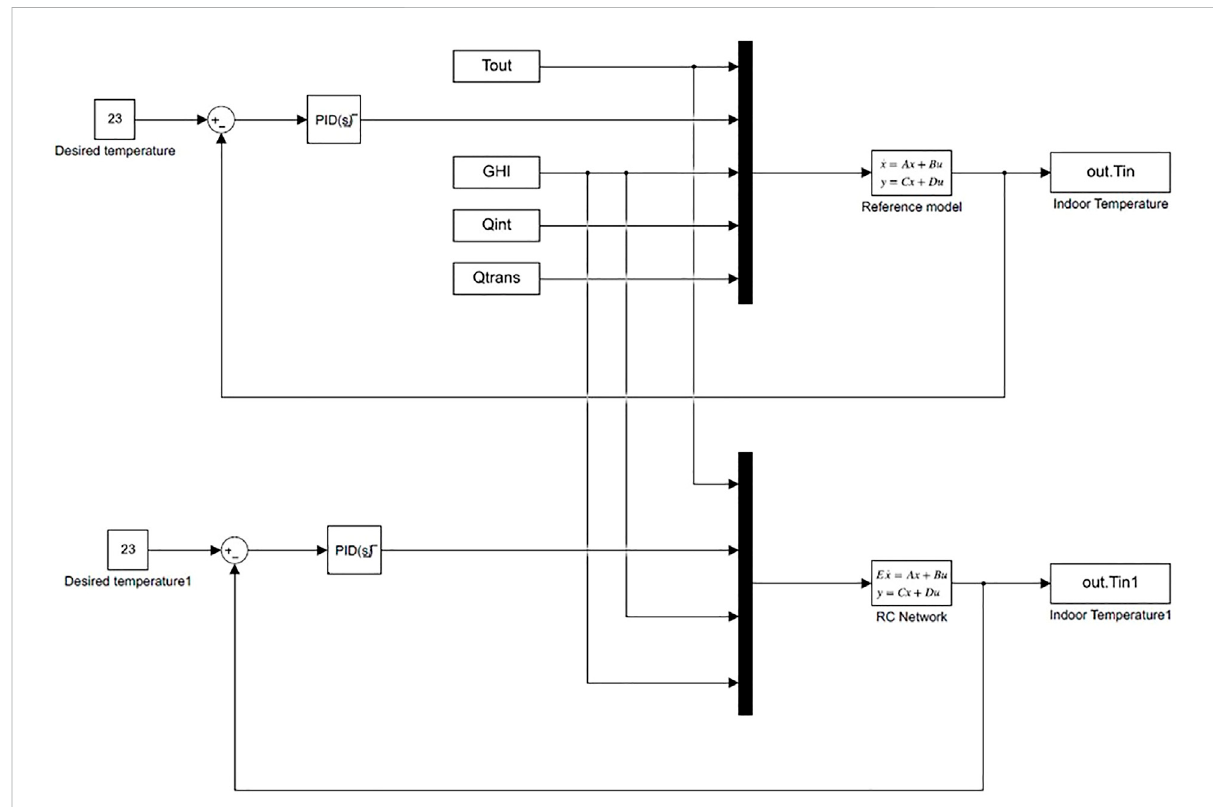
FIGURE 9 Control loop implemented in